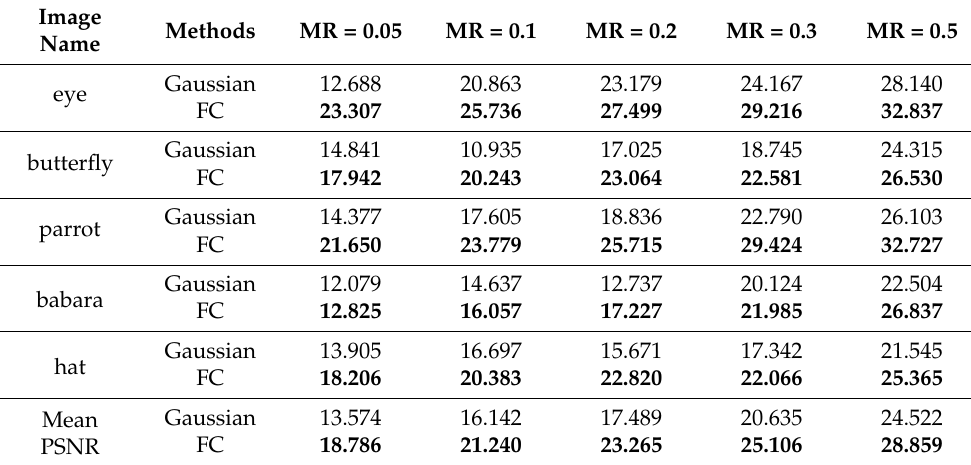
Figure 8. Imaging results of DAPA using different DIP reconstruction networks at 0.2 measurement